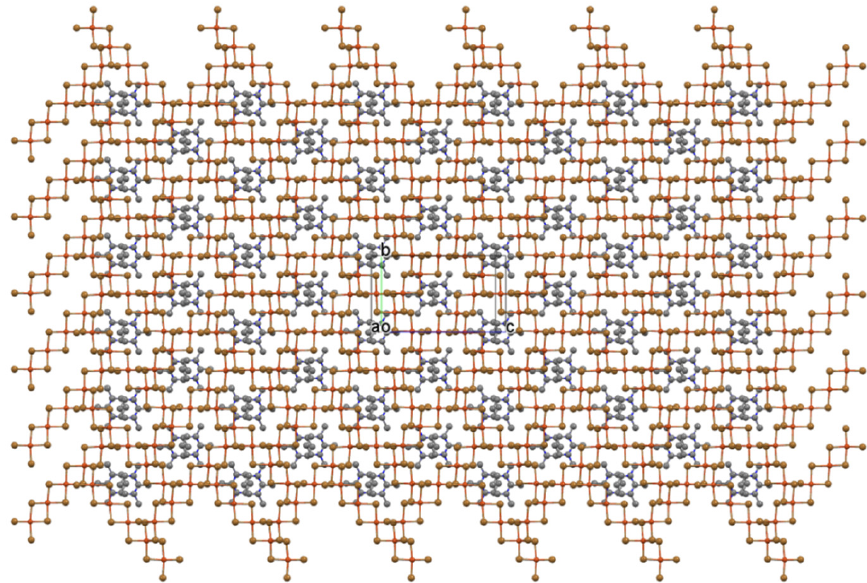
Figure 4. Ball-and-stick plot of the cross-hatched oligomer layer in Figure 4, but now with inversion- related organic cation pairs nested into the depressions in the layer.